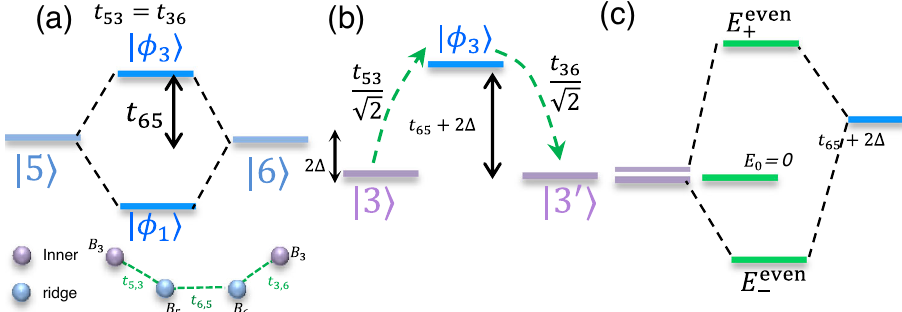
(cid:3) (cid:3) (cid:4) (cid:4) (cid:3) (cid:3) and anti-bonding ϕ orbitals between the ridge atoms 5 (cid:3) (cid:4) 1 2 (cid:3) of two ridge (cid:3) (cid:4) 3 (cid:3) and it is set to zero. c Energy diagram after the formation of